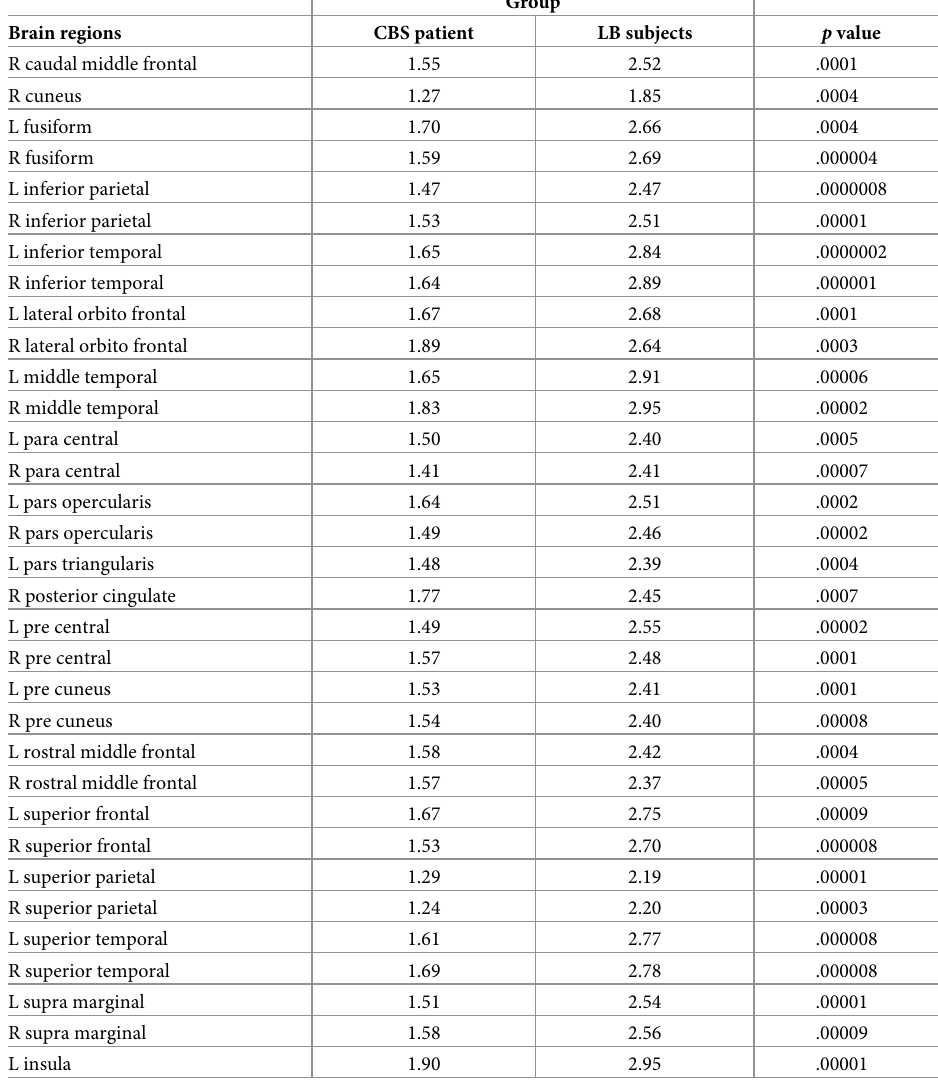
Table 3. Cortical thickness differences between CBS patient and LB